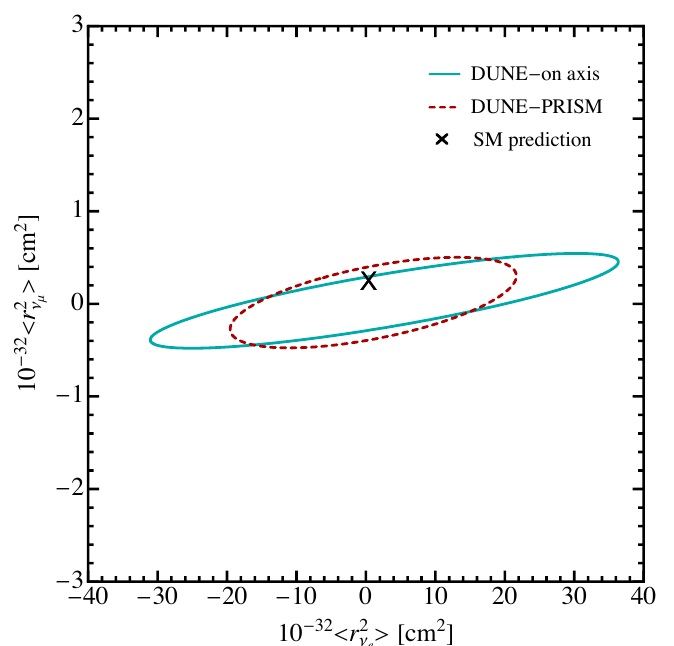
Figure 8 . Here we summarize our projected 90 % C.L. constraints from DUNE on neutrino charge radius in both a fully on-axis scenario (solid blue) as well as an off-axis DUNE-PRISM setup (dashed red), where the black “X” labels the SM